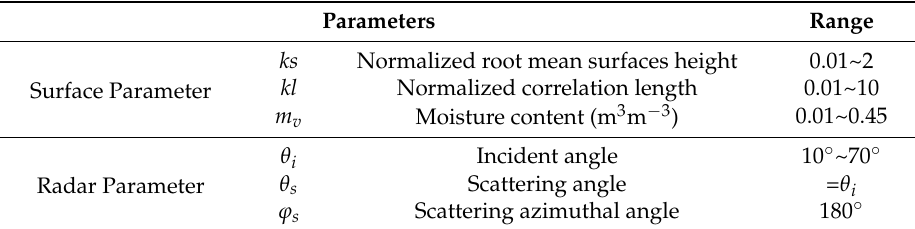
Table 1. Simulation surface and radar